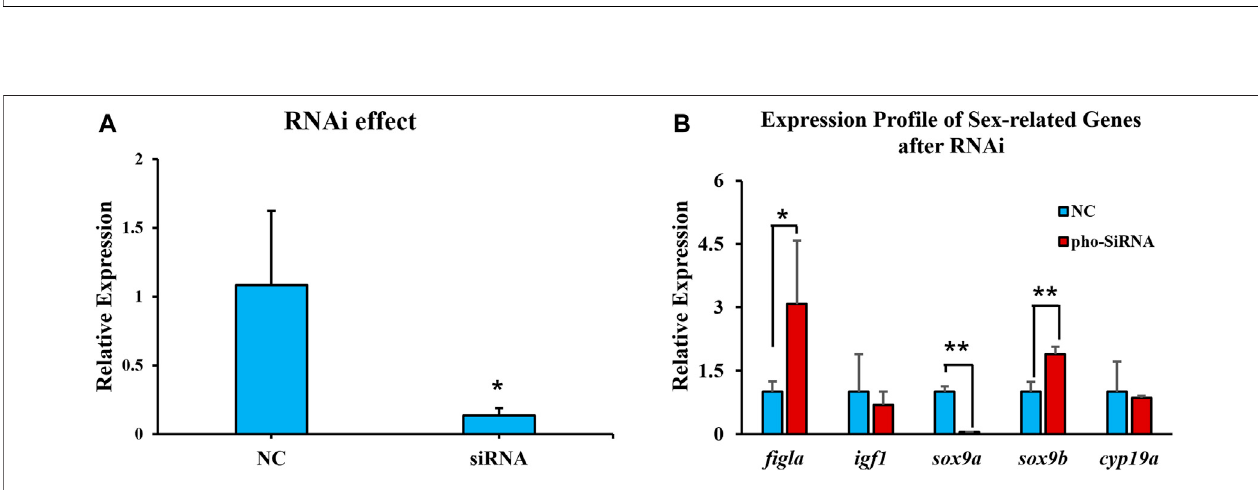
FIGURE 5 | Expression levels of pitp β _w and sex-related genes in the ovarian cell line after RNAi for 48 h (A) Expression of pitp β _w after siRNA. (B) Expression of fi gla_tv1 , igf1 , sox9a , sox9b ,and cyp19a afterRNAi.NC,negativecontrolgroup.siRNA, rchy1-siRNA -treatedgroup.Asterisksindicatesigni fi cantdifferences(* p < 0.05; ** p <